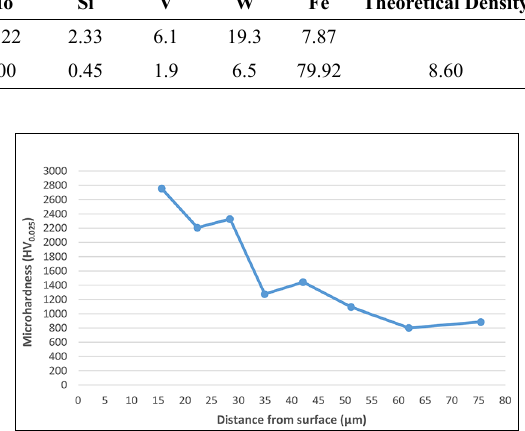
Figure 2. Microhardness behavior of boride